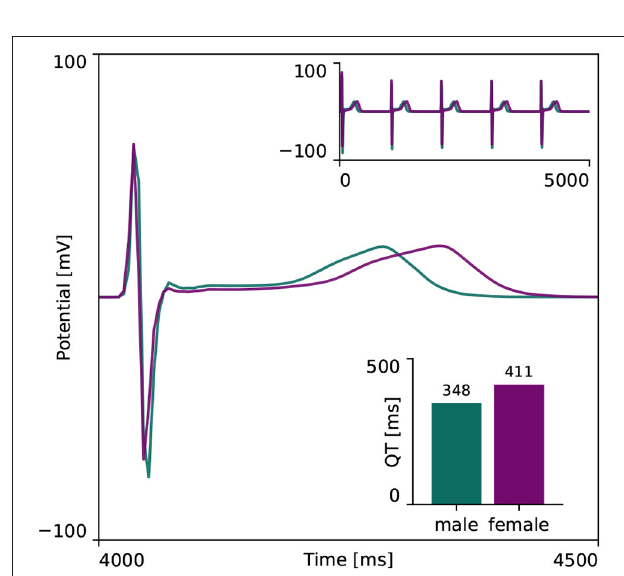
FIGURE 5 | Baseline electrocardiogram recordings for the male and female heart . Electrocardiogram recordings for the male and female heart models without drugs. Both male and female electocardiograms display regular periodic activation patterns, as shown in the upper right inlay plot. The repolarization delay between the male and female heart is shown in more detail in the main plot, focusing on the first 500 ms of the last simulated beat. The resulting male and female QT interval amounted to 348 and 411 ms, respectively, as shown in the lower right inlay